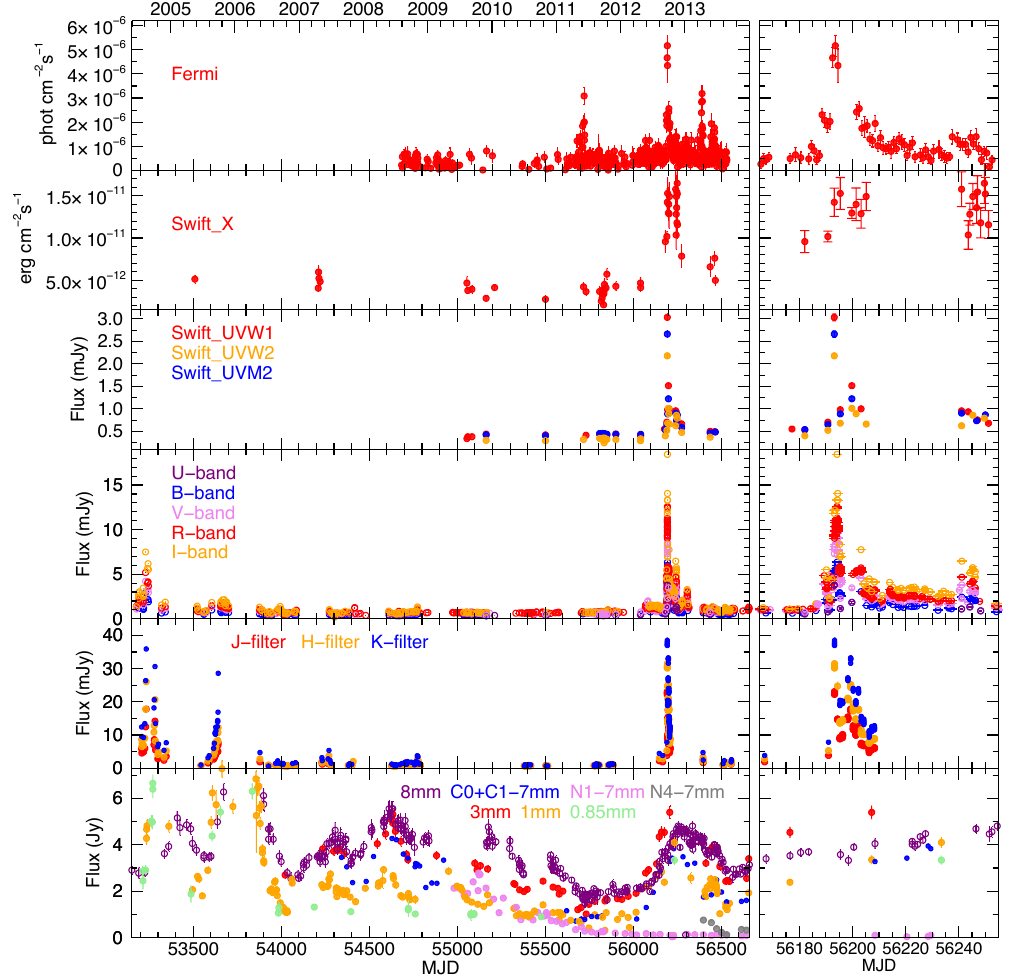
Figure 2. Light curves of CTA 102 from γ -ray to millimeter wavelengths. From top to bottom: γ -ray, X-ray, UV, optical, NIR, and millimeter-wave data; Left panel: data from May 2004 to January 2014; Right panel: expanded view during the γ -ray outburst between August and November 2012. Reproduced from [8] by permission of the